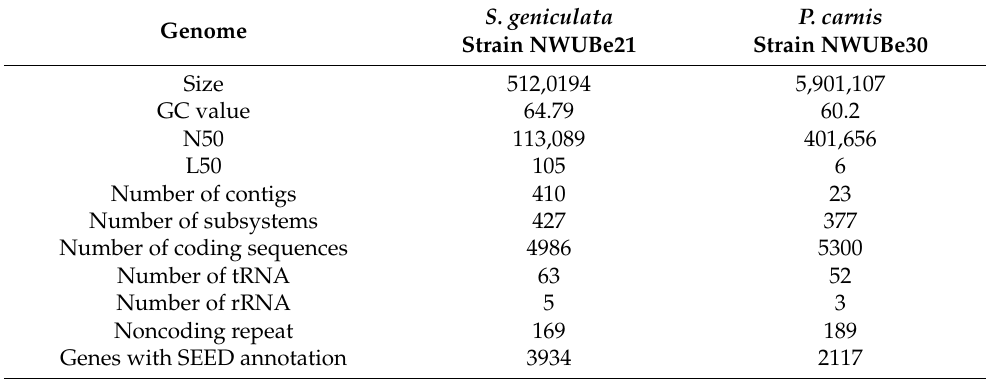
Table 2. Genomic overview of endophytic strains S. geniculata NWUBe21 and P. carnis